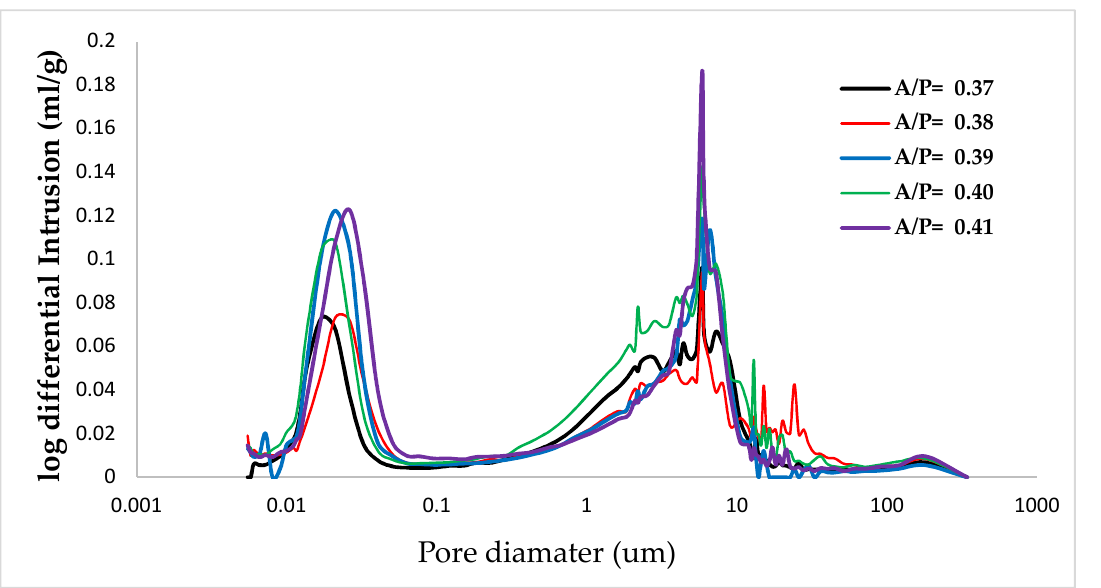
Figure 12. The cumulative pore volume curve for specimens cured for 28 days.